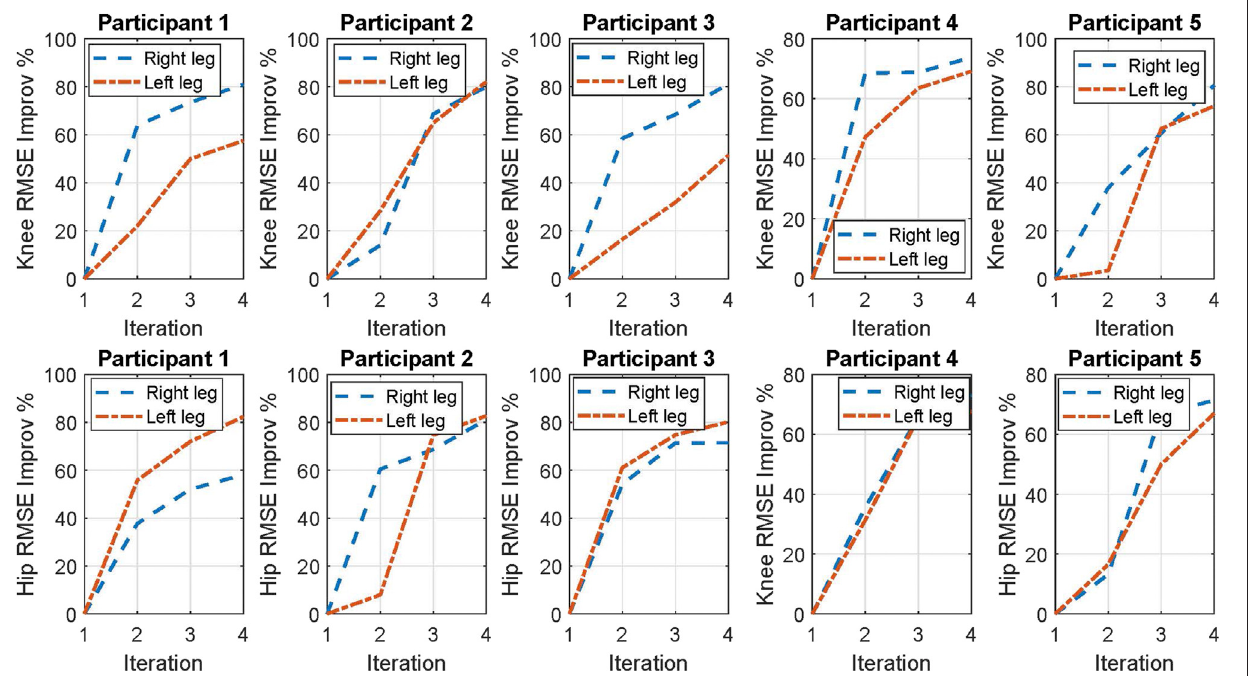
FIGURE 5 | RMSE improvement percentage of both knee and hip joints from the 1st to the 4th iterations for each participant.